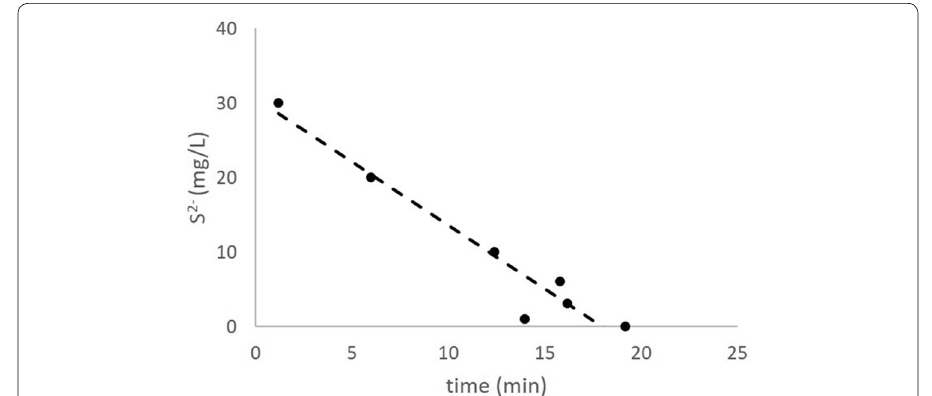
Table 4 Pre-experiment III: mixing a 40% FeCl solution with thermal water in different 3 ratios Mixing ratio FeCl 3 added (mg/L) pH Suspension color Hydrogen 1: 100 2000 1.3 Red nm 200 2.8 nm